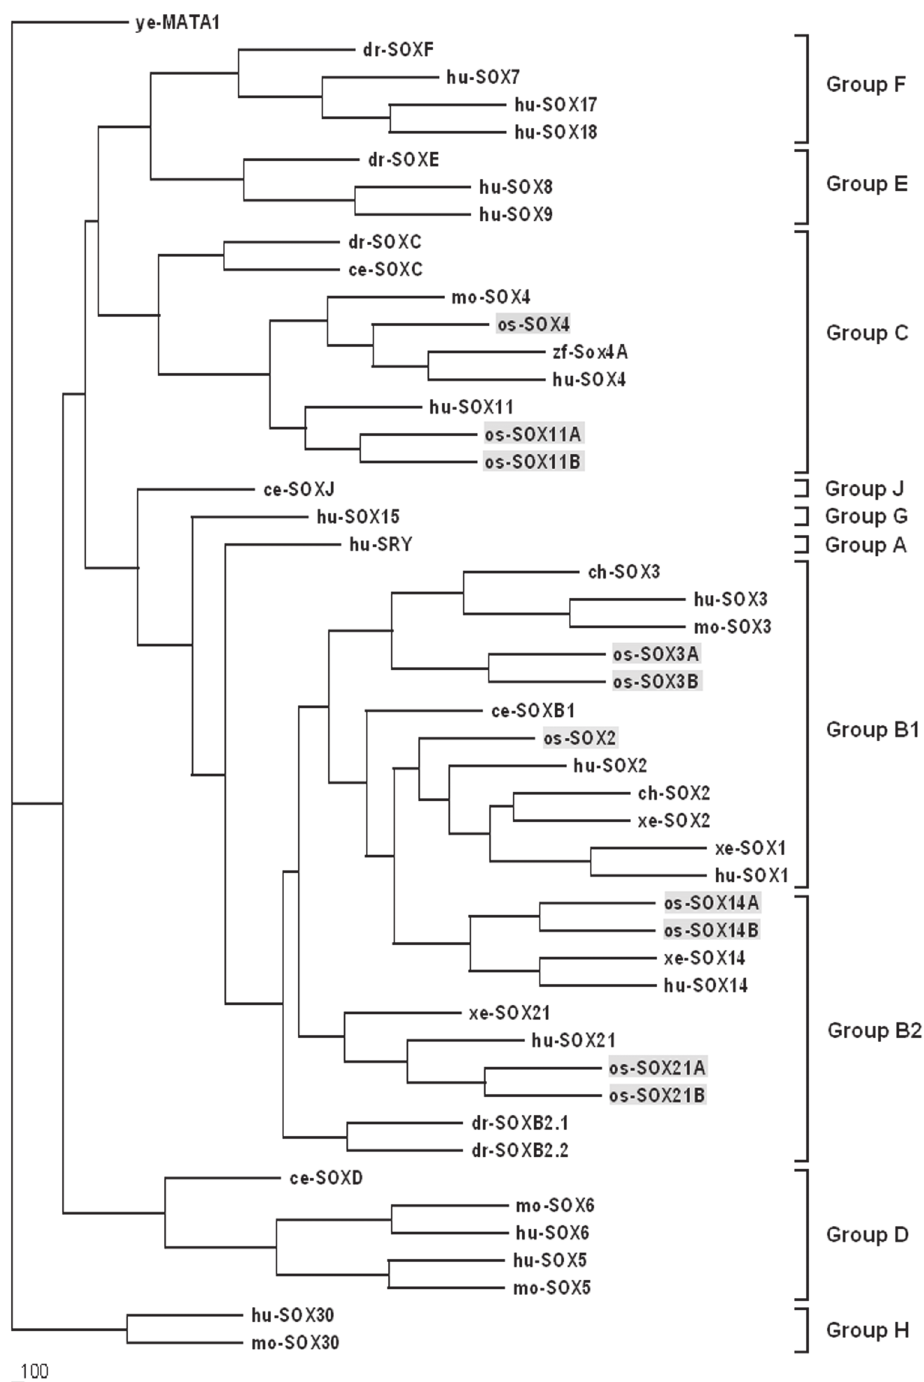
Figure 4. Phylogenetic neighbor-joining tree of Sox gene family. An alignment of the HMG domain sequences was made with Clustal X; this was used to derive a phylogenetic tree with PHYLIP software by the neighbor-joining method and the output tree was displayed by TreeView (v1.6.6) without any adjustment. Bootstrapping was carried out on 1000 replicates. Based on the tree and pervious data, genes were ascribed to groups A, B, C, D, E, F, G, H, or J. The Sox genes belonging to O. schmackeri are